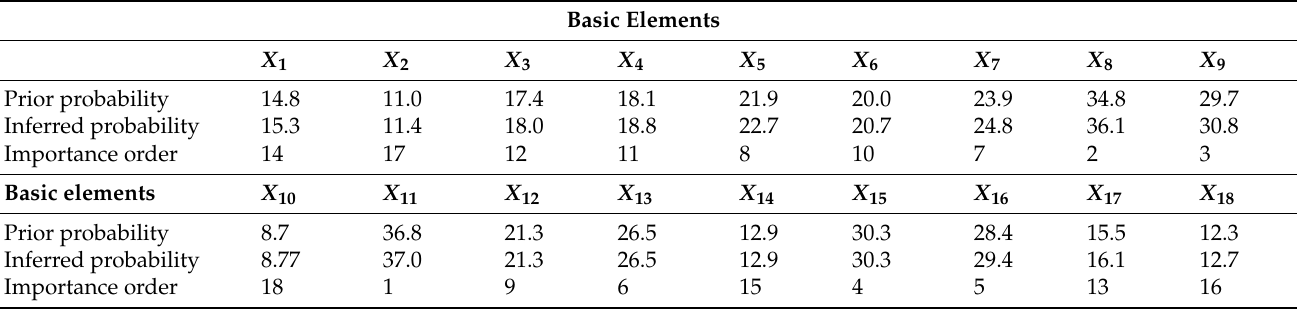
Table 2. The diagnosis reasoning results. Basic